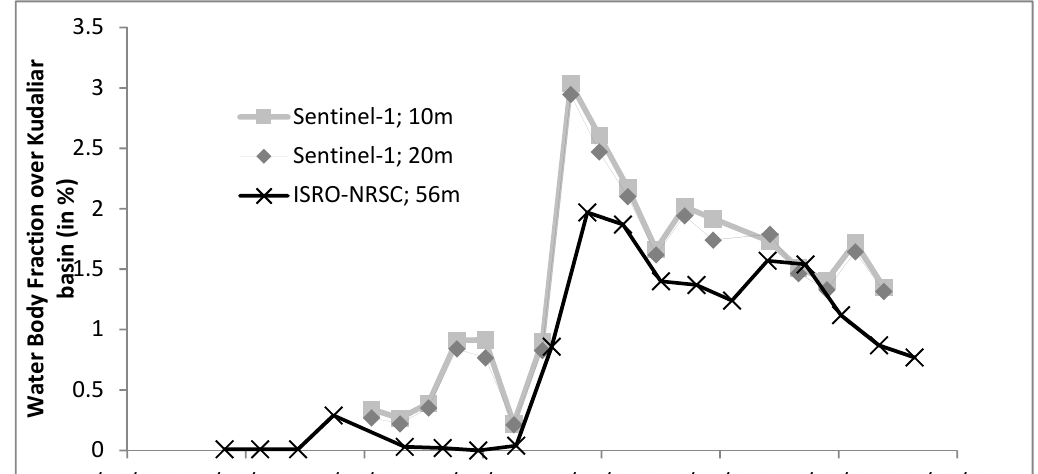
Figure 8. Water Body Fraction estimates in Kudaliar experimental watershed, from the classification of each of the 18 Sentinel-1 acquisitions at 10 and 20 m spatial resolution over the Kudaliar watershed, using the RF classifier. This dataset is compared to the national Water Body Fraction database, which contains the Water Body Fraction at 5 km resolution based on optical remote sensing at 56 m resolution (source: ISRO-Bhuvan web